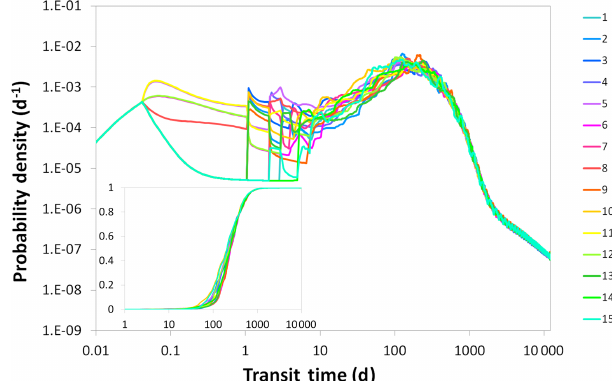
Figure 5. 15 TTDs resulting from 15 different precipitation time series with all other catchment and climate properties being equal. The first few events have the largest influence on the TTD shapes, while subsequent events gradually even out the differences. Inset shows cumulative